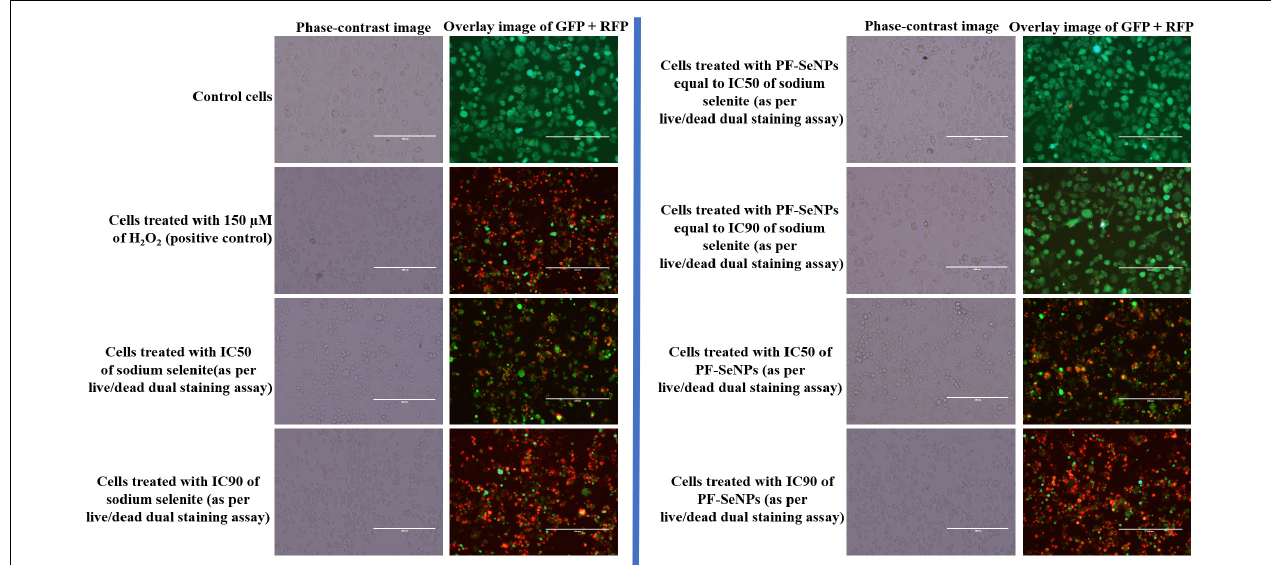
FIGURE 10 | Live/dead dual staining images of N2a cells treated with 150 µ M of H 2 O 2 and different concentrations of sodium selenite and phytofabricated selenium nanoparticles (PF-SeNPs) for 24 h. The scale bar is 200 µ m.